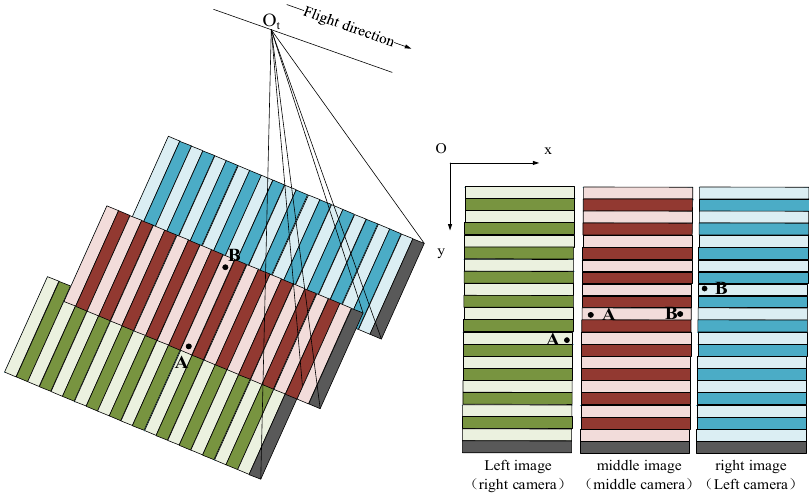
Figure 2. Pushbroom imaging mode of AWSHRHIS.